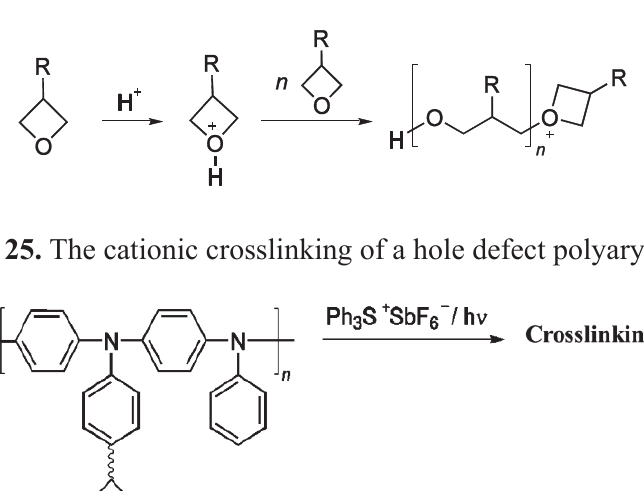
Figure 24. CROP of oxetanes (R = Polymer chain with oxetane side groups (for the source of H + , see e.g., Figure 22)).